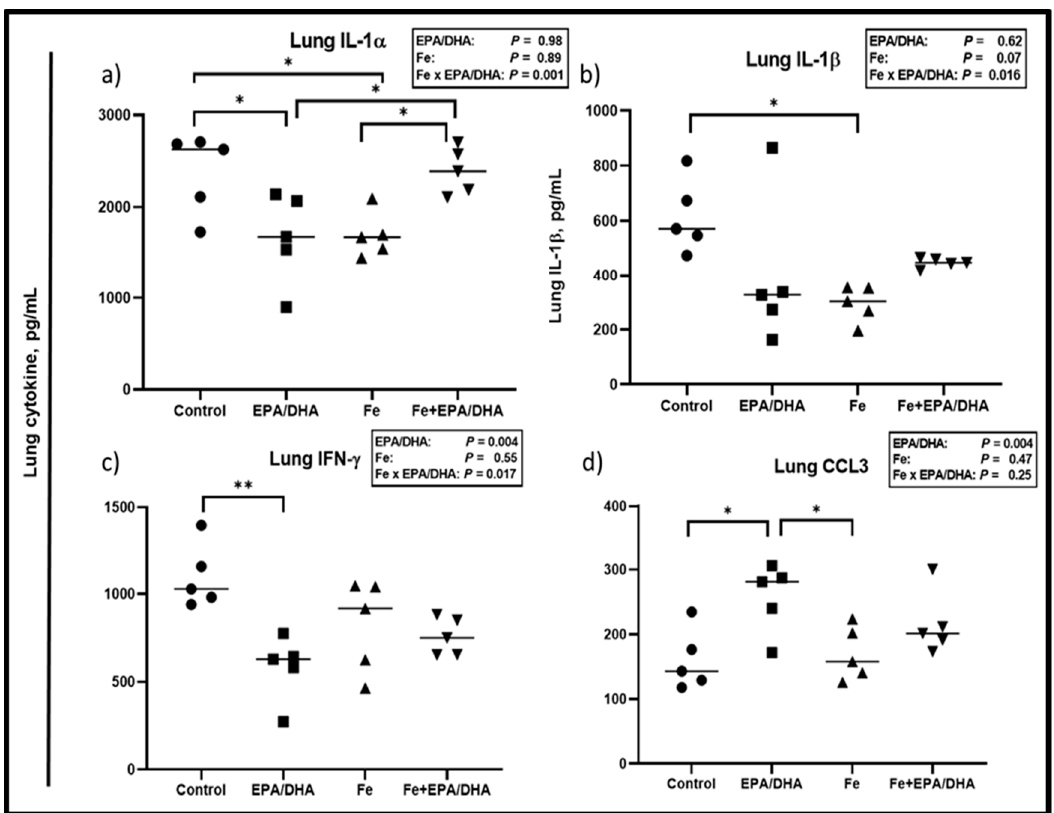
Figure 5. Lung cytokine concentrations after providing Mtb -infected mice with control, EPA / DHA, Fe, or Fe + EPA / DHA diets for three weeks, including ( a ) IL-1 α , ( b ) IL-1 β , ( c ) IFN- γ , and ( d ) CCL3. Results repeated in two experiments, data shown for one experiment ( n = 5 per group). Two-way ANOVA was used to test the e ff ects of EPA / DHA (control & Fe vs. EPA / DHA & Fe + EPA / DHA), Fe (control & EPA / DHA vs. Fe & Fe + EPA / DHA), and Fe × EPA / DHA interactions. One-way ANOVA followed